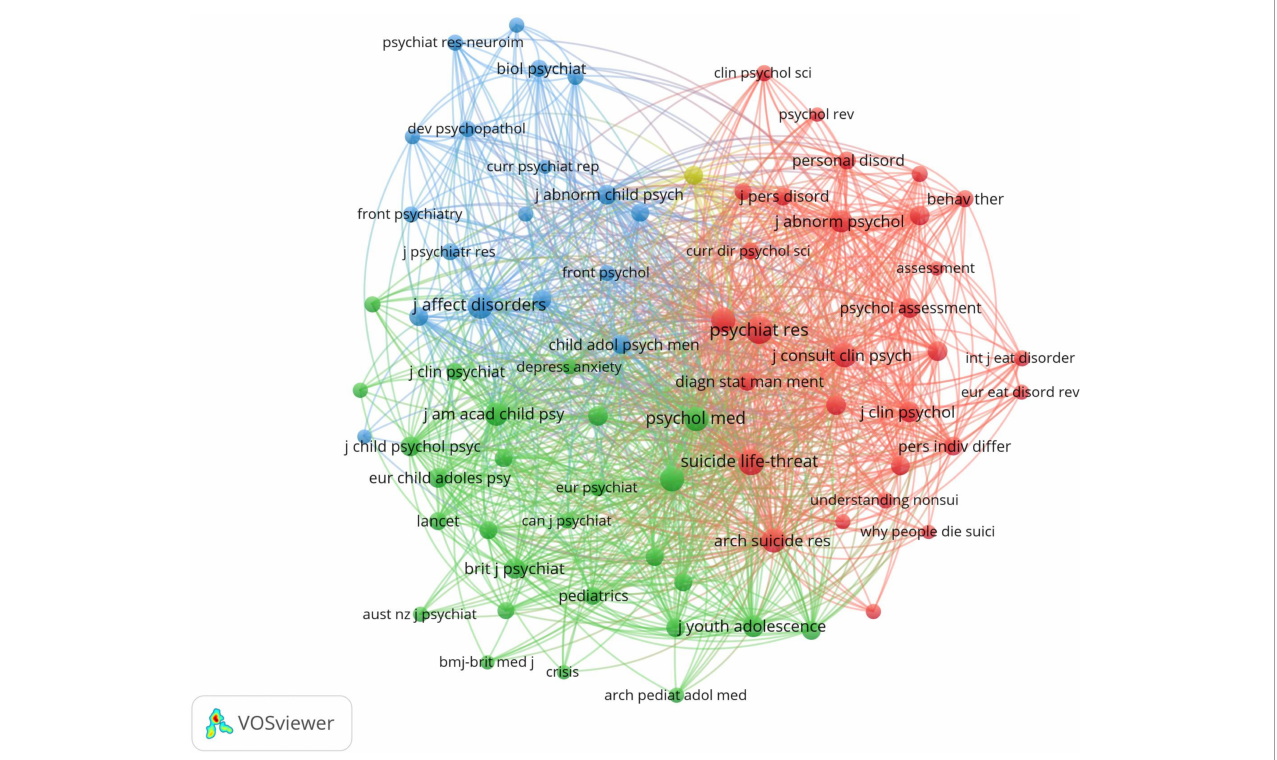
FIGURE6 Network visualization map of journal co-citation analysis generated by VOSviewer. Each node represents a co-citation journal and each color represents one cluster, the links between nodes represents co-citation of journals.